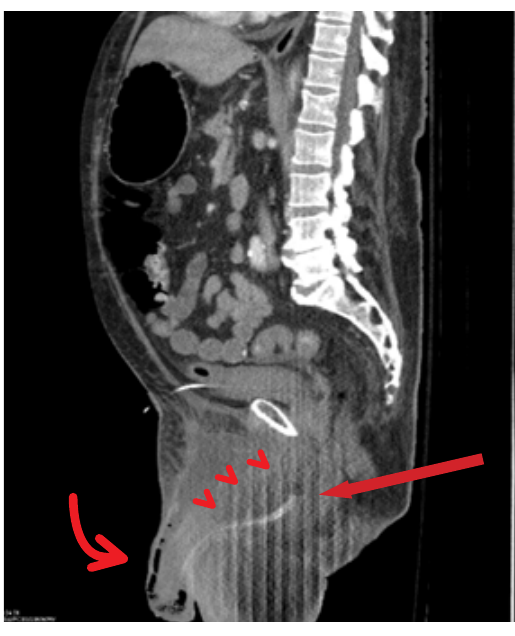
figure 2 – Distended bladder and significant fluid accumula- tion with interspersed gas in the pre- and retrourethal space (arrows). Tip of the catheter (dotted arrow) appeared to be outside the urethra and angled posteriorly.